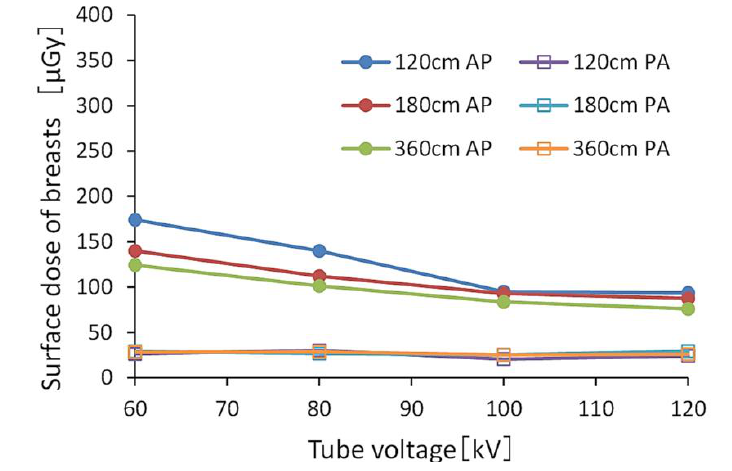
Figure 2. Breast surface doses (BSDs) when changing the tube voltage without a grid. (AP: anteroposterior, PA: posteroanterior).